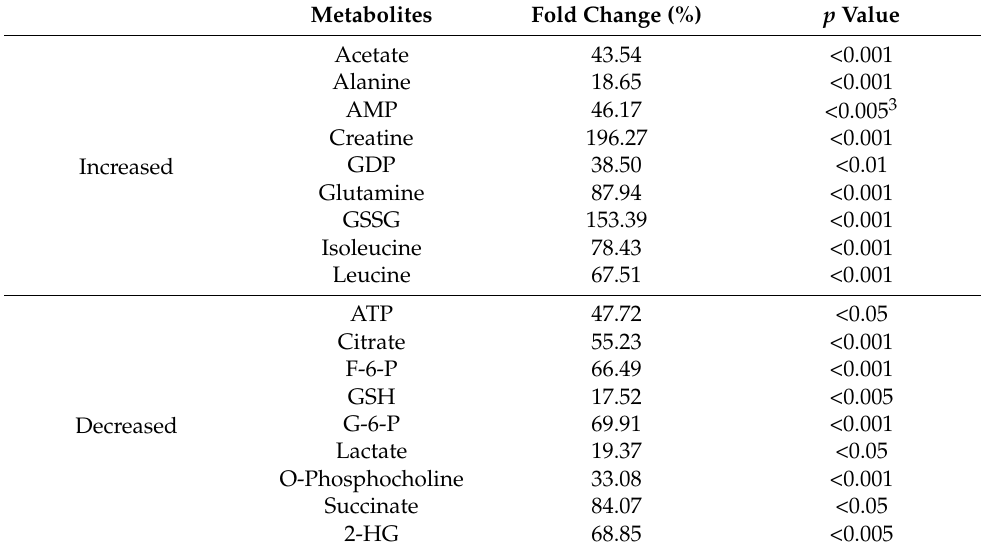
Table 1. Metabolite changes in MCF-7 cells after metformin treatment measured by an NMR and LC/MS